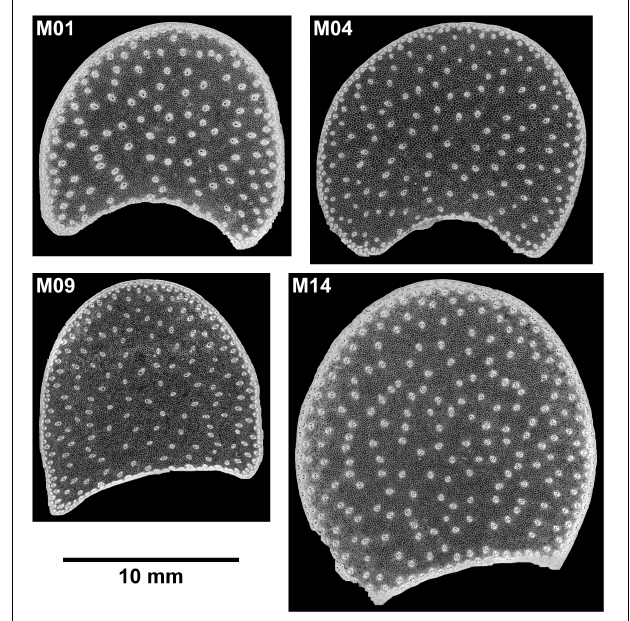
FIGURE 2 | BlueBox images. Example of large images for four inbred lines. The large image reveals the stem section area, rind, vascular bundle repartition, and